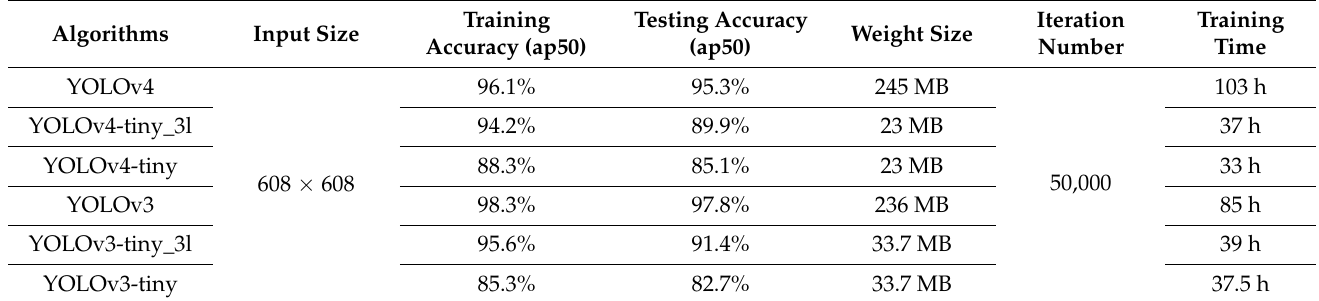
Table 6. Comparing all YOLO networks based on a large